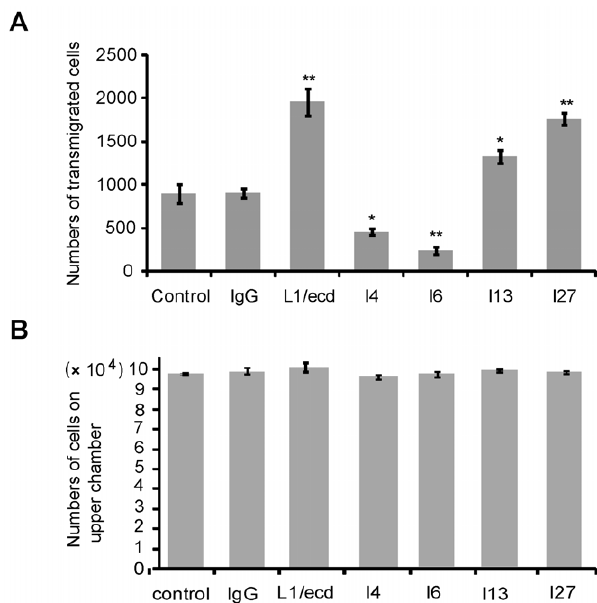
Figure 5. ScFvs against Ig1–4 inhibit, while scFvs against Fn1–3 stimulate transmigration of SK-N-SH cells. Equal numbers of cells (10 5 ) were seeded into the upper compartment of a transwell chamber and allowed to migrate through a BSA-coated membrane for 36 hours. ( A ) Cells that had migrated into the lower chamber containing L1/ecd (12 m M), non-immune human IgG (10 m M), and scFvs I4 (16.5 m M), I6 (16.5 m M), I13 (16.5 m M), or I27 (16.5 m M) are shown. Omission of scFvs served as negative control. Migrated cells were fixed on the membrane